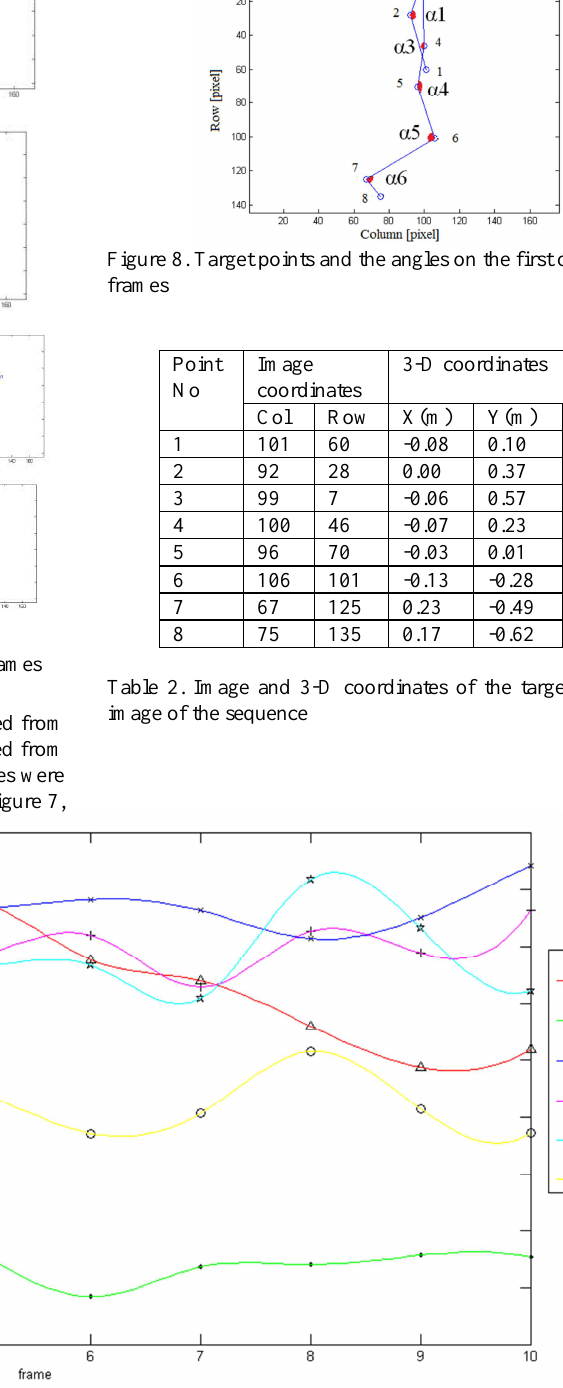
Figure 9. The angles between the body parts during the